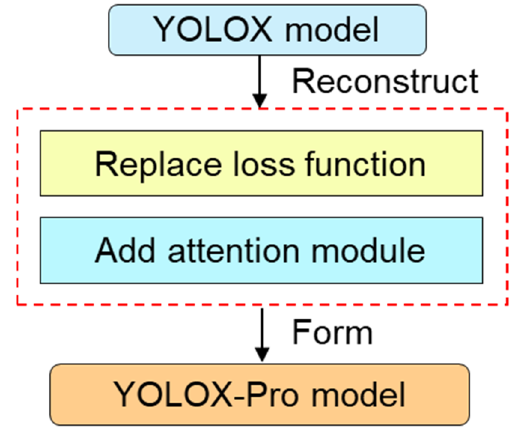
Figure 8. Model design flowchart. Table 2. The Parameters of YOLOX and YOLOX-Pro.